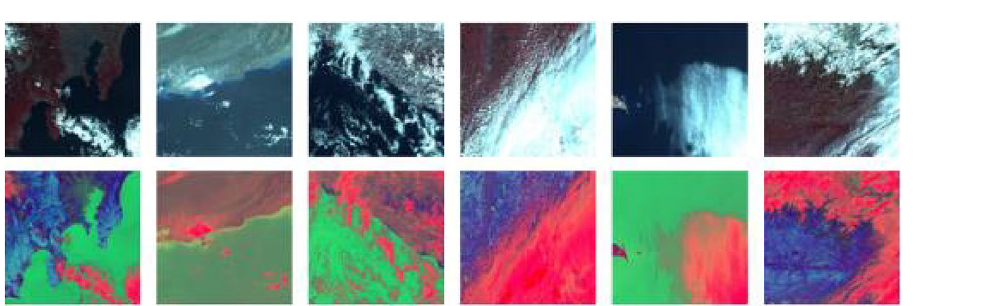
Figure 3. Flowchart of the method presented in this paper.